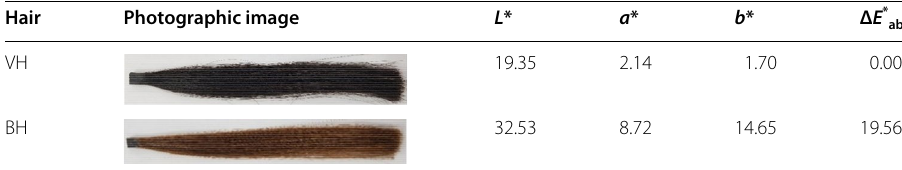
Table 5 CIELAB color values of virgin hair (VH) and bleached hair (BH) Hair Photographic image